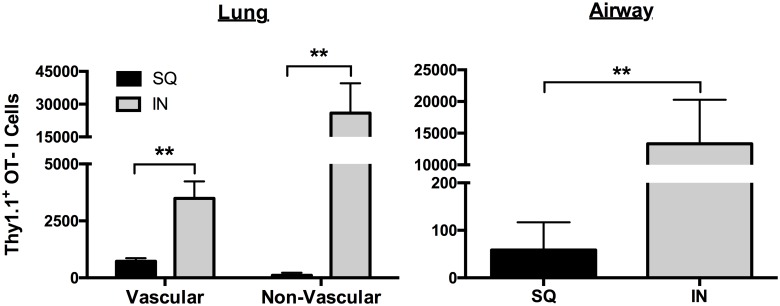
Memory CTLs in the lung vasculature, parenchyma and airways following IN vaccination with ADJ-OVA.Thy1.1+ve naïve OT-I TCR transgenic CD8 T cells were adoptively transferred into C57BL/6 mice. Twenty-four hours after cell transfer, mice were vaccinated with ADJ-OVA by the SQ or IN routes. Three weeks after the first vaccination, mice received a booster vaccination. Twenty-one days after the booster vaccination, OT-I cells in vasculature, parenchyma and airways were quantified by flow cytometry. Vascular OT-I CD8 T cells were identified by intravascular staining; mice were infused intravenously with anti-CD8β antibodies 5 minutes before euthanasia. Following euthanasia, cells in the BAL and lungs were stained with anti-Thy1.1, anti-CD8α, anti-CD103, anti-CXCR3 and anti-CD69 antibodies. Vascular OT-I cells were identified based on positivity for both CD8α and CD8β and non-vascular cells were positive only for CD8α. Data is from one of two independent experiments; ** indicates p<0.01.